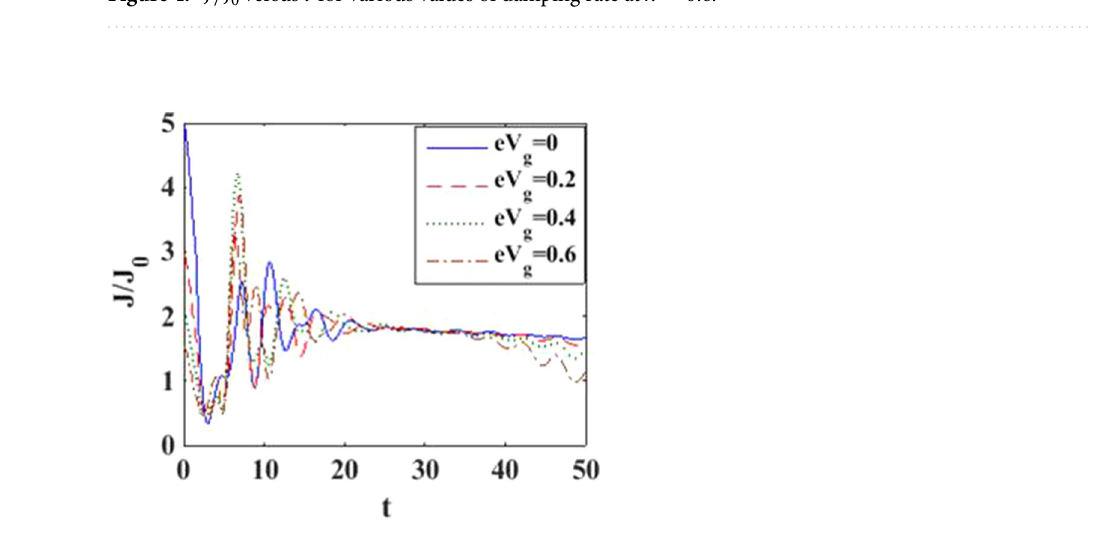
Figure 5. J / J 0 versus t for various values of eV g at (cid:31) = 0.6 .